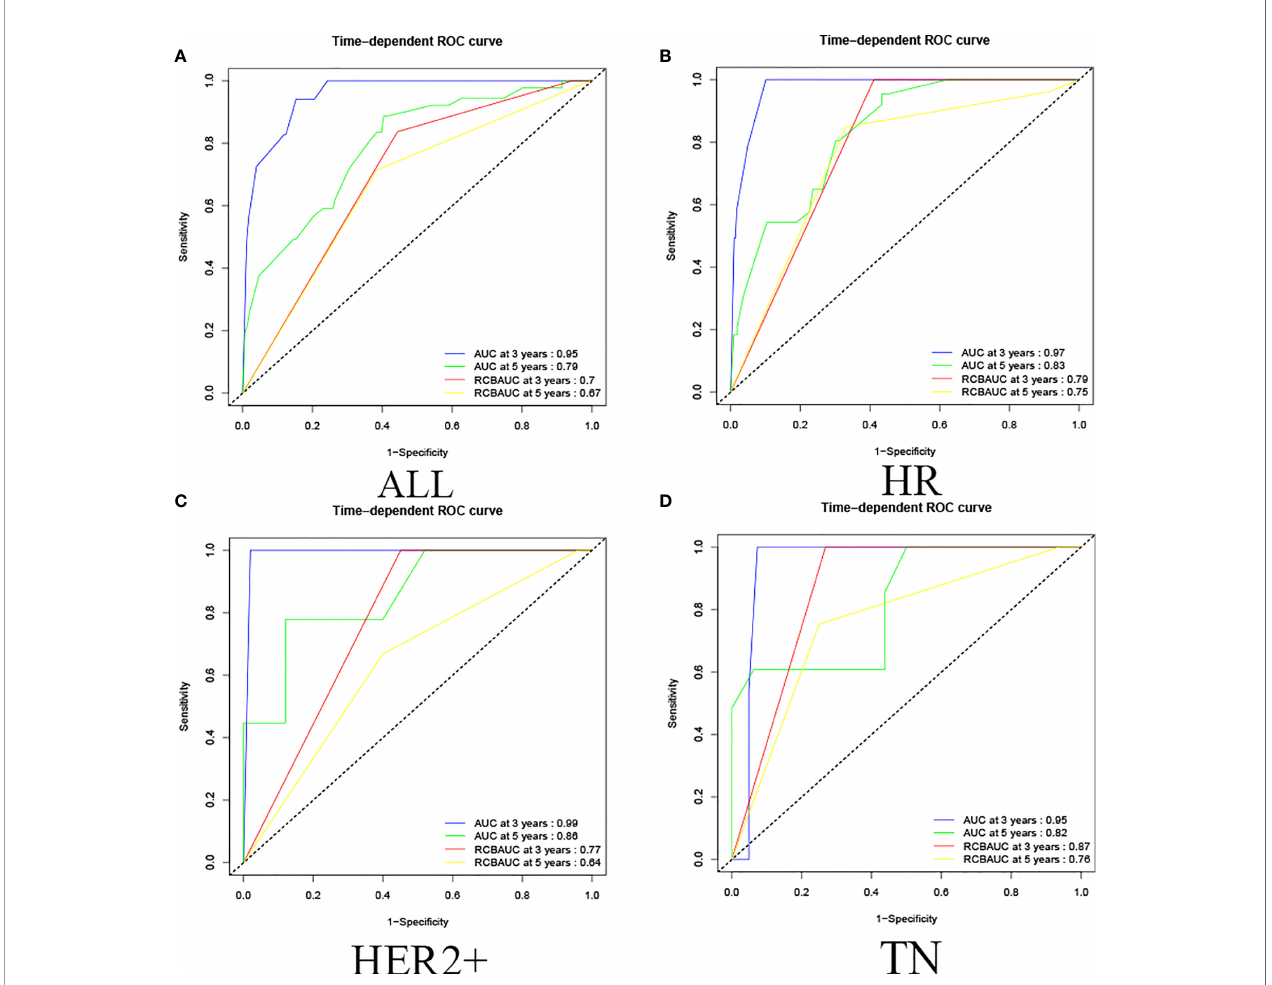
FIGURE 4 | Training set ROC curve. (A) Among all cases in the training set, the prediction model predicted that the 3-year survival AUC value was 0.95 and the 5- year survival AUC value was 0.79, and the RCB classi fi cation of 3-year survival and 5-year survival were 0.70 and 0.67. (B) In HR, the AUC values of 3-year and 5- year survival rate calculated by predictive model were 0.97 and 0.83, the RCB classi fi cation of 3-year survival and 5-year survival were 0.79 and 0.75; (C) in HER2+, the AUC values of 3-year and 5-year survival rate calculated by predictive model were 0.99 and 0.86, the RCB classi fi cation were 0.77 and 0.64; (D) in TN, the AUC values of 3-year and 5-year survival rate calculated by predictive model were 0.95 and 0.82. The RCB classi fi cation were 0.87 and